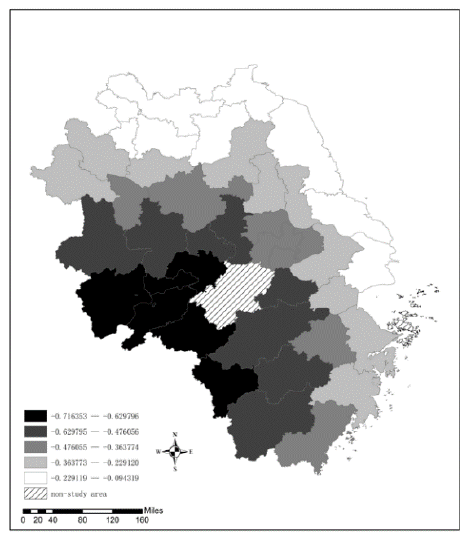
Figure 6. The spatial distribution of the regression coefficient for Ind .